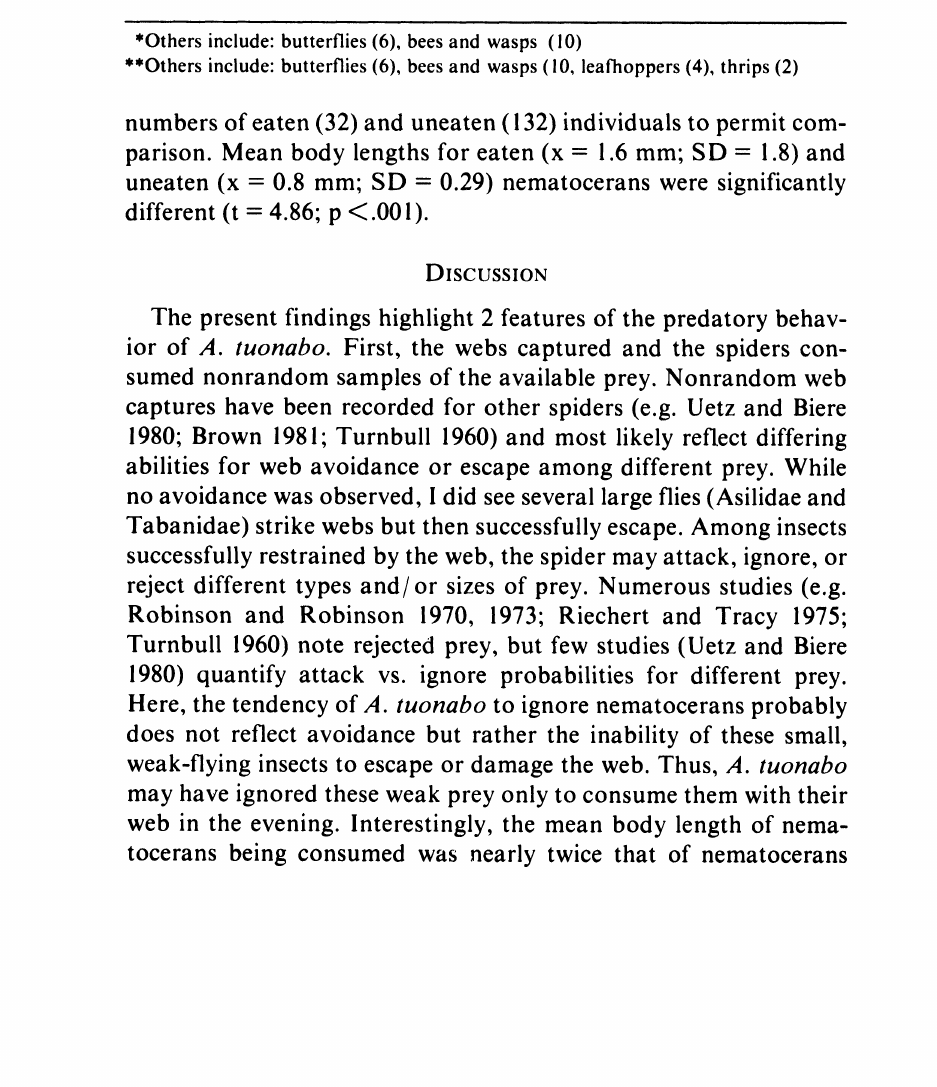
Table 2. Spider selectivity (E s) values for prey types collected from webs of A. tuonabo. Prey